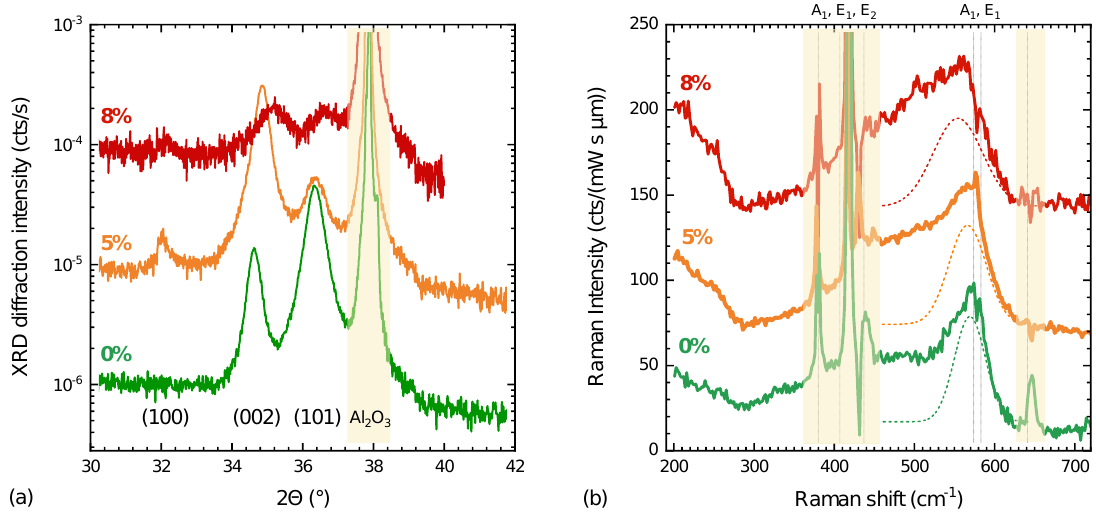
Figure 6. ( a ) X-ray diffraction of atomic layer deposition (ALD) grown ZnO and ZnO:Al samples with increasing Al content; ( b ) background subtracted Raman spectra of the same samples. Regions with strong substrate contributions have been shaded. The broad ZnO response was deconvoluted for each sample by two broad Gaussian peaks. For clarity only the deconvoluted E 1 mode is shown (dashed